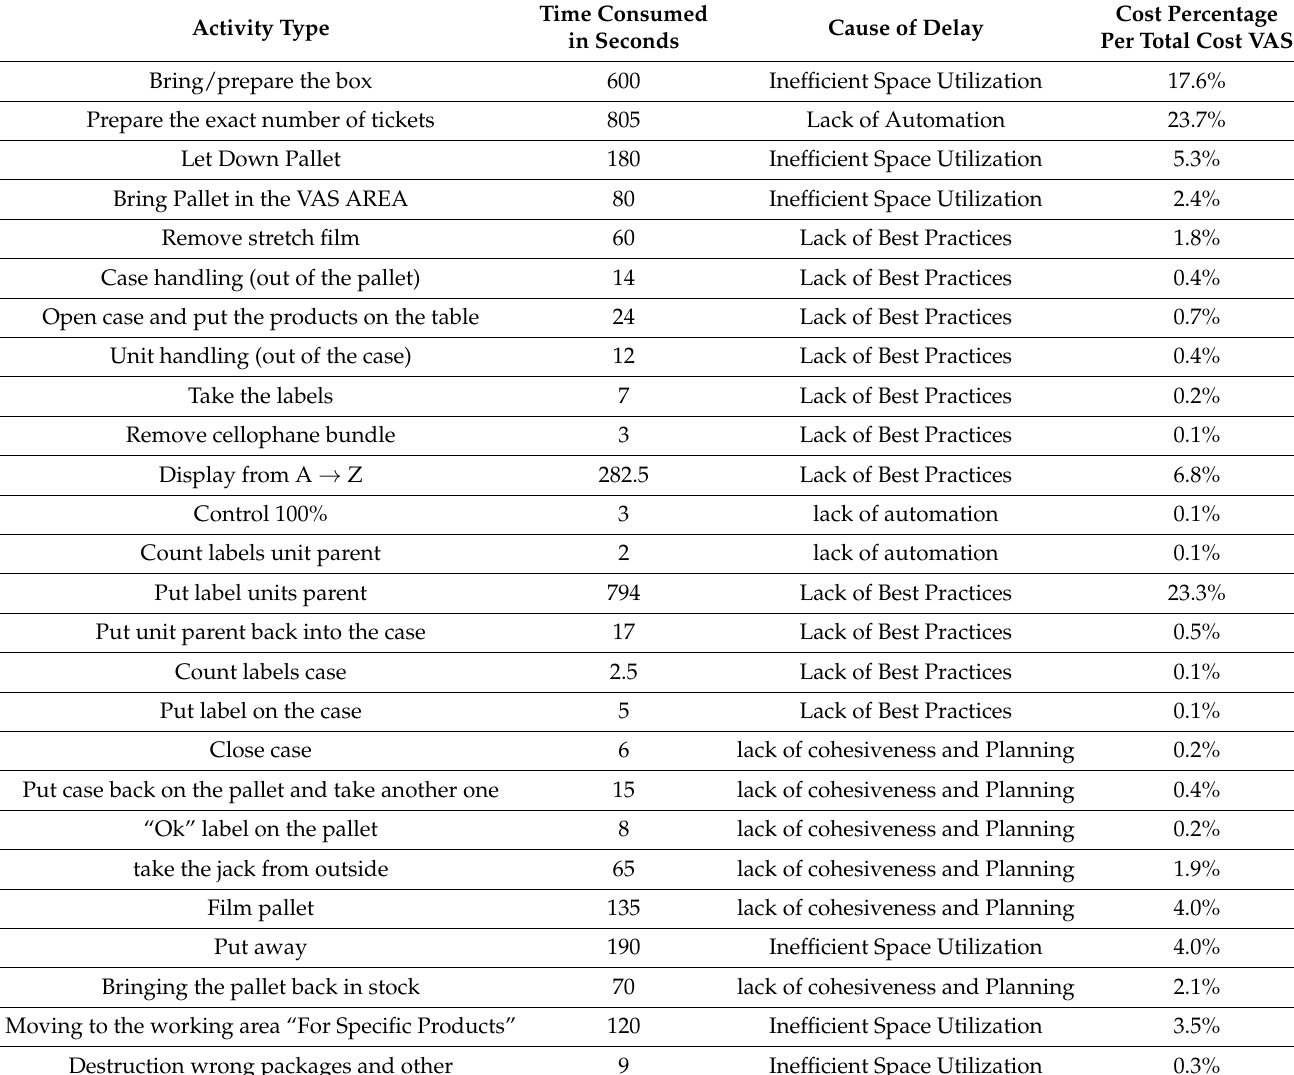
Table 4. Ophthalmic antihistamines and